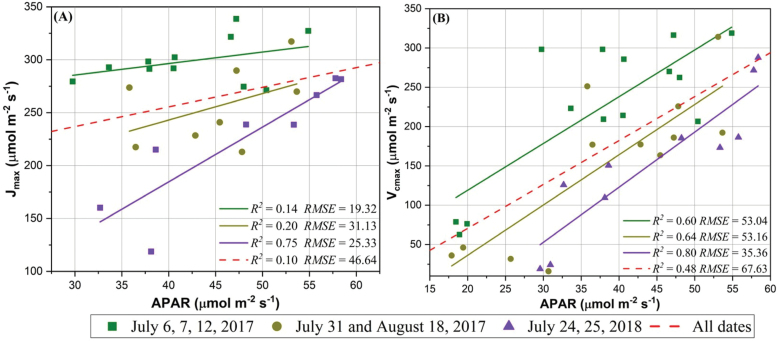
The relationship between APAR and (A) Jmax and between APAR and (B) Vcmax.